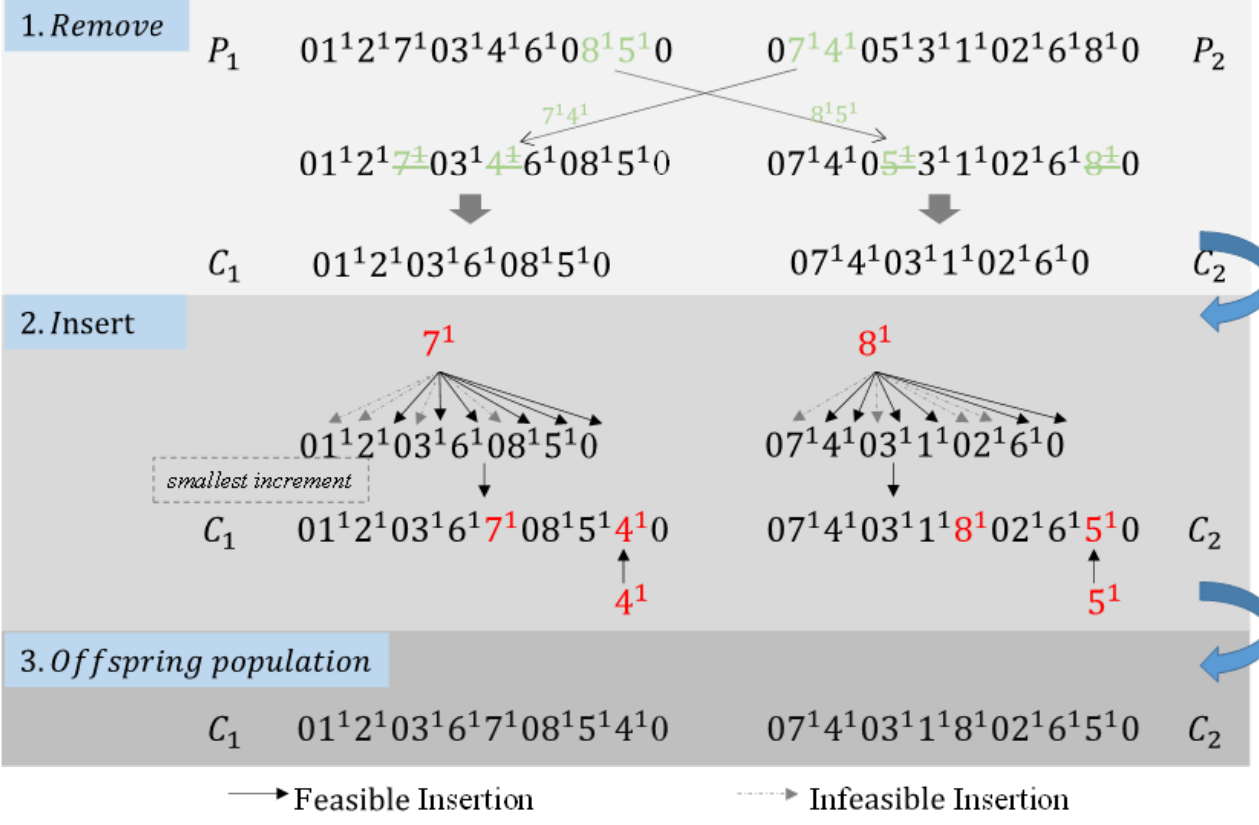
Figure 4. An example of the BCRC crossover operator.